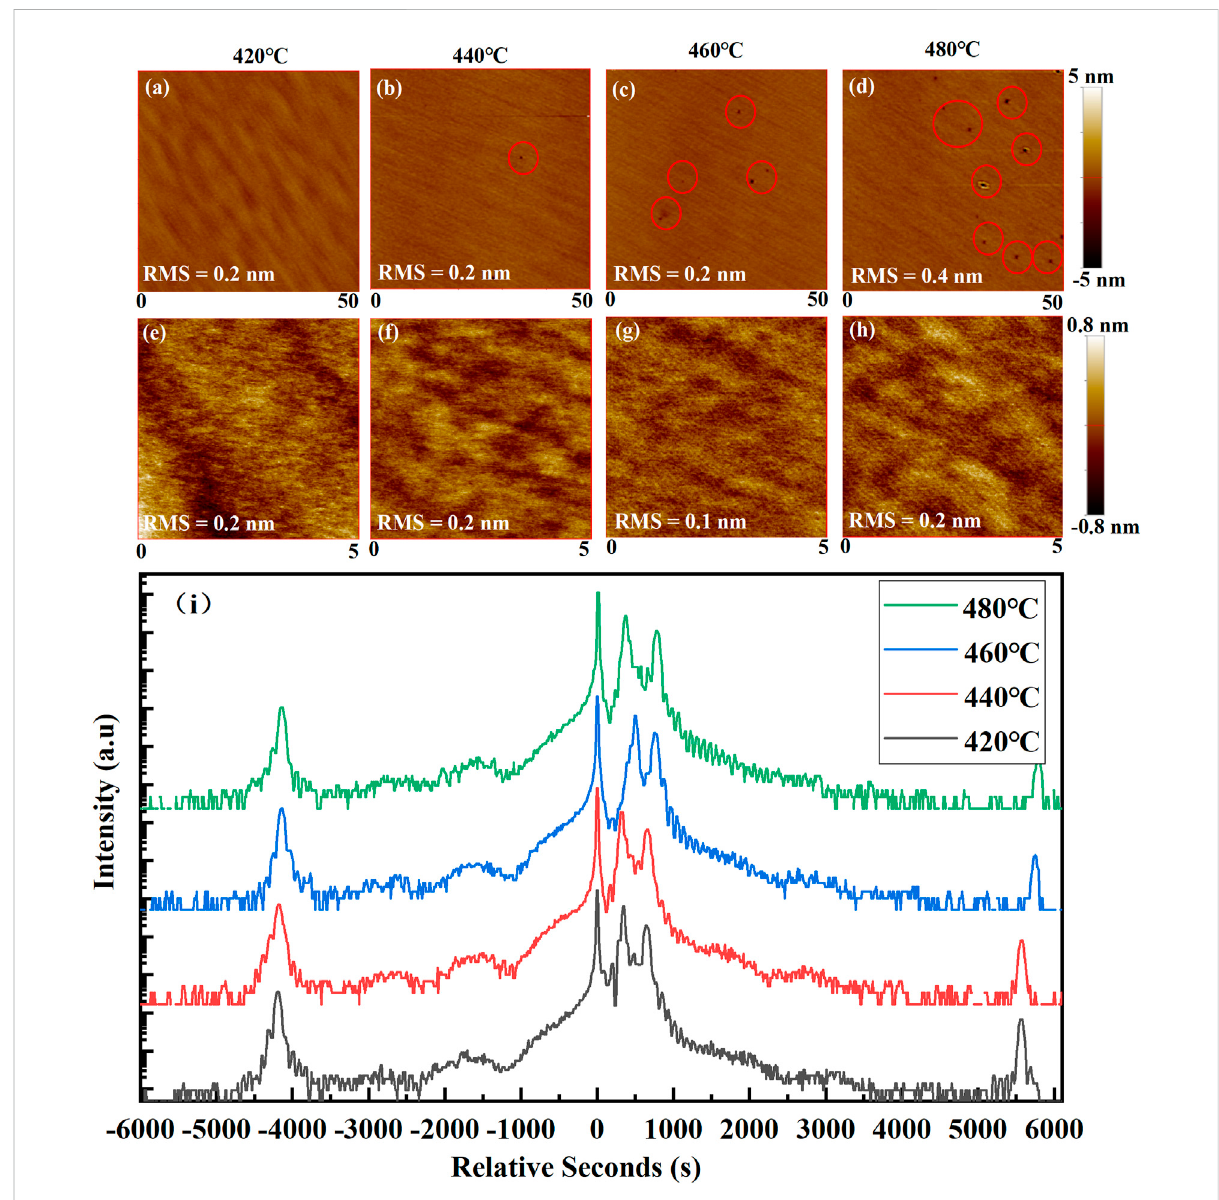
FIGURE 3 (A – H) AFM and (I) double crystal x-ray diffraction images of 60 periods of 2 nm-InGaAs/2 nm-InAlAs/InP superlattice in different growth temperature. The estimated root mean square (RMS) of surface roughness is